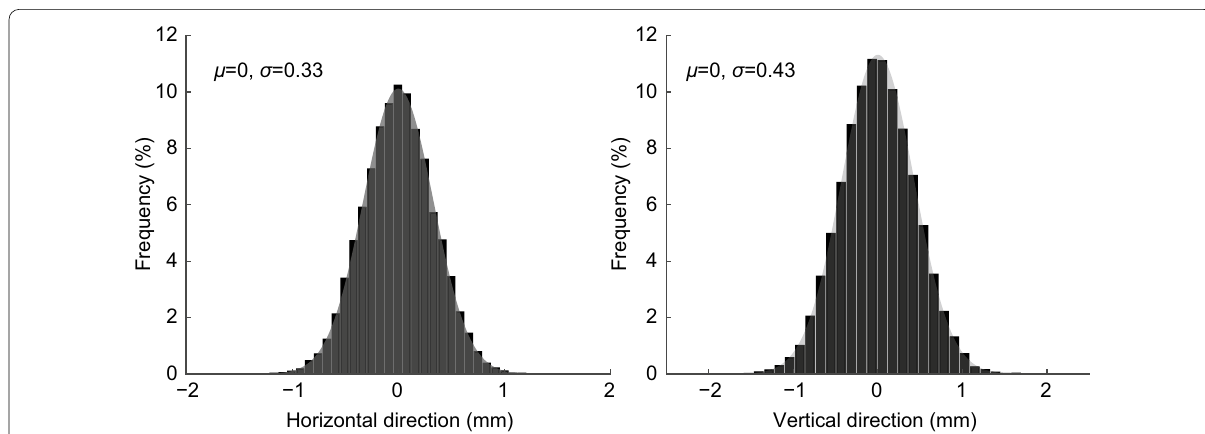
Fig. 4 Histogram of the short-wave track irregularity measurement error incurred by the aided